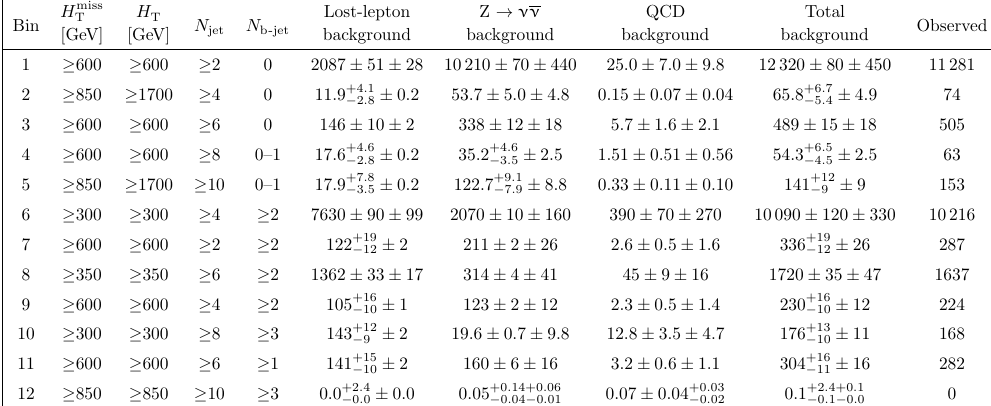
Table 9 . Selection criteria, pre-(cid:12)t background predictions, and observed number of events for the 12 aggregate search bins. For the background predictions, the (cid:12)rst uncertainty is statistical and the second